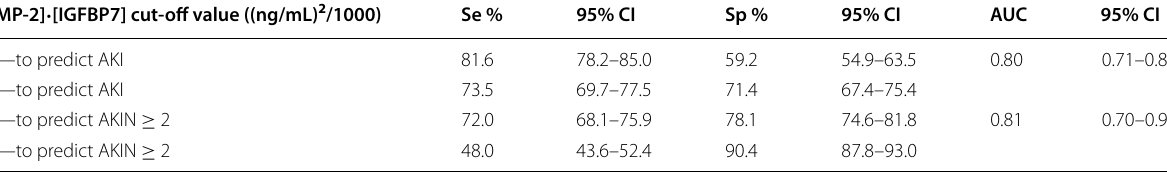
[IGFBP7] for AKI compared with gold standard AKIN classification ·